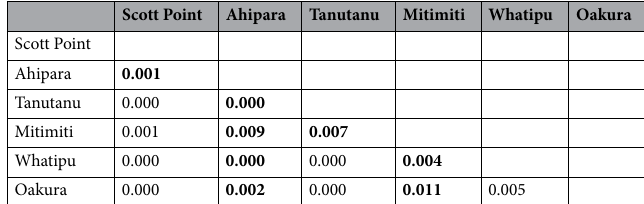
Table 3. Pairwise F ST values for the six samples of Perna canaliculus assessed over all 10 loci. Negative F ST values have been set to zero. Significant values of F ST after FDR testing are in